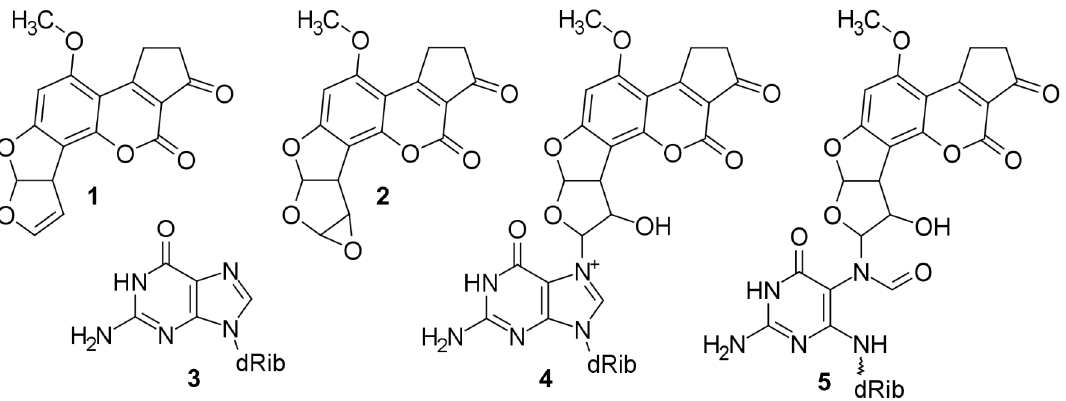
Figure 1. Structural formulae. 1 , AFB 1 ; 2 , AFB1-E; 3 , Gua; 4 , Cationic Gua-N7-9-hydroxy-AFB 1 ; 5 , FAPy-N7-9-hydroxy-AFB 1